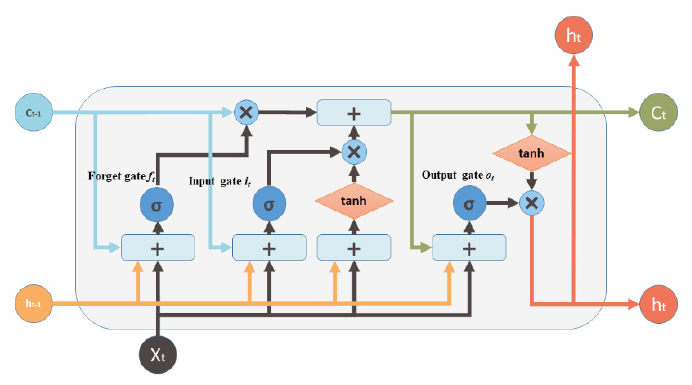
Figure 5. Long short-term memory (LSTM) structure diagram.